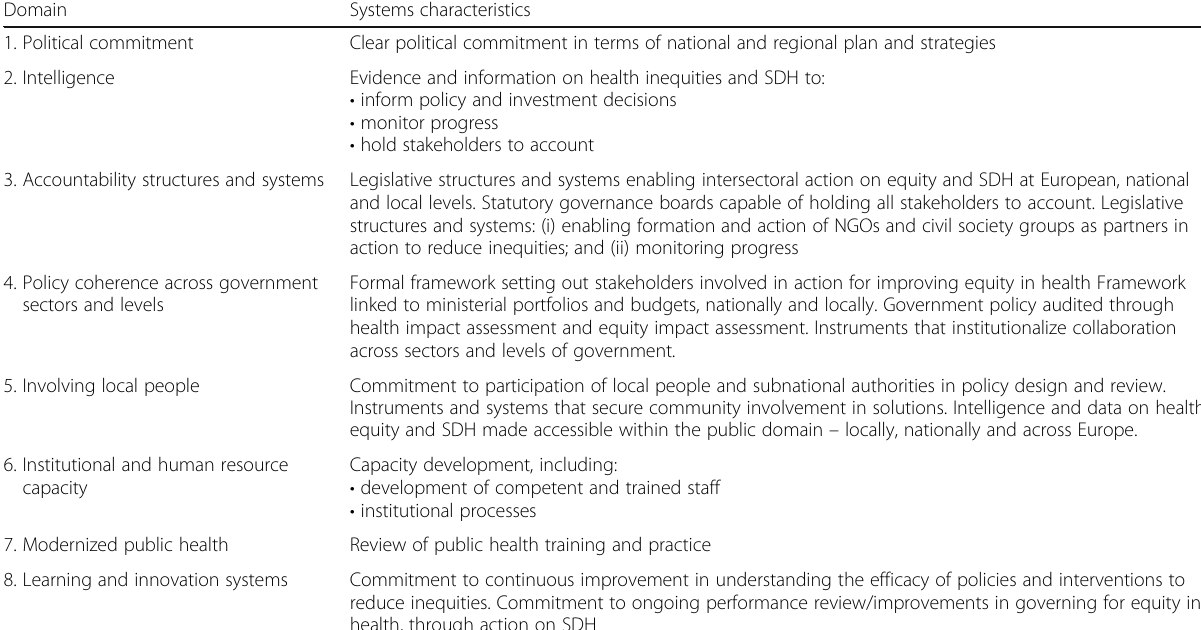
Table 1 Governance domains and system characteristics Domain